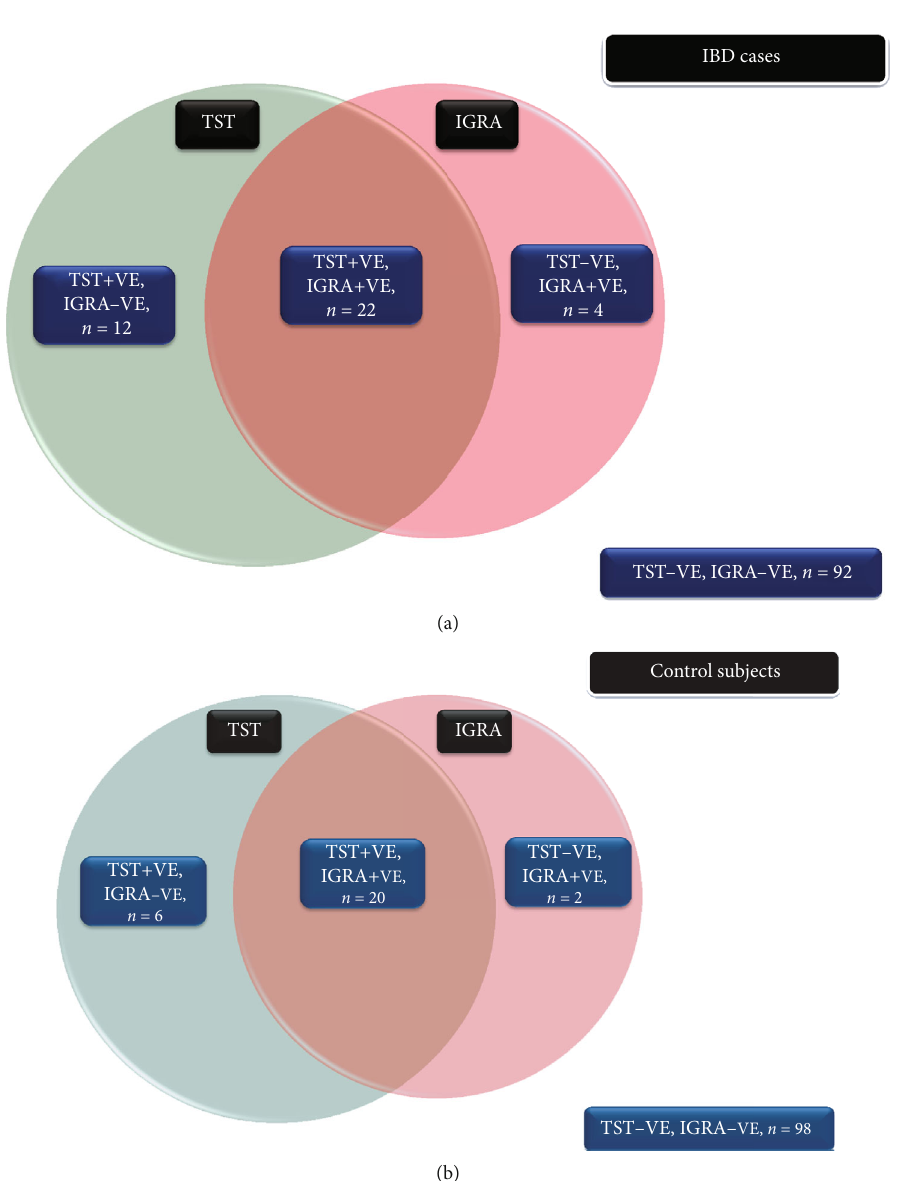
Figure 1: (a) Venn diagram shows the distribution of LTBI among IBD patients. (b) Venn diagram shows the distribution of LTBI among control